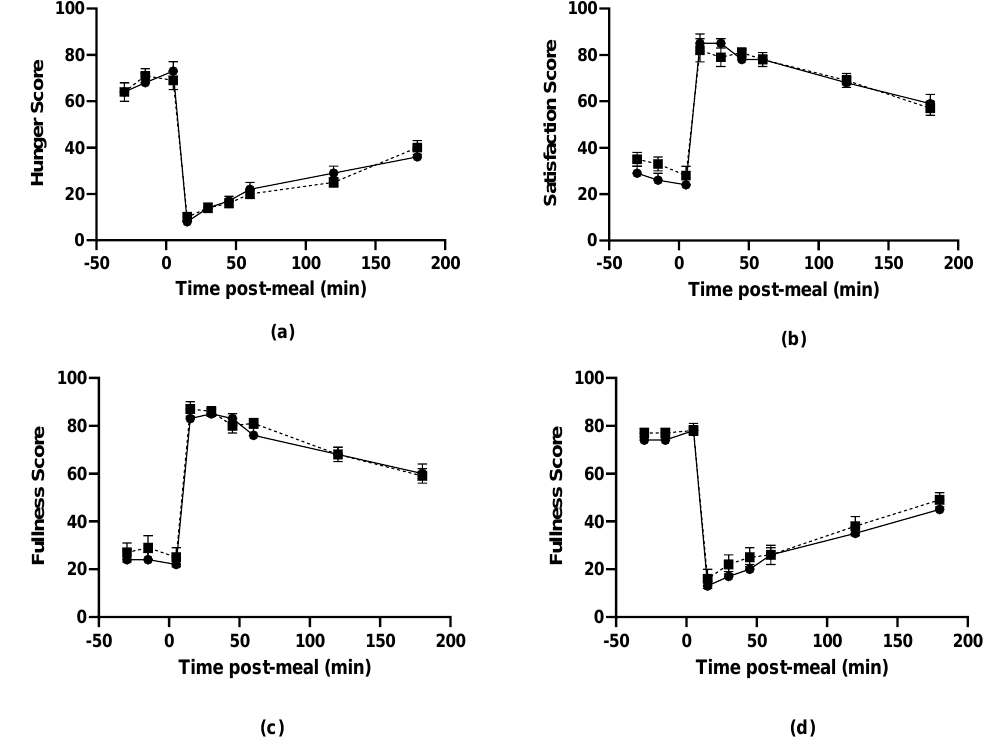
Figure 3. Measures of ( a ) Hunger, ( b ) Fullness, ( c ) Satisfaction and ( d ) Desire to eat, as assessed using a validated visual analogue scale (VAS) before and after consumption of the pasta lunch meal prepared with plant-based (closed circles and solid lines) and beef (closed squares and dotted lines) mince. There were no differences in any of these measures either before or after consumption of the test meals (repeated measures ANOVA, p < 0.05).